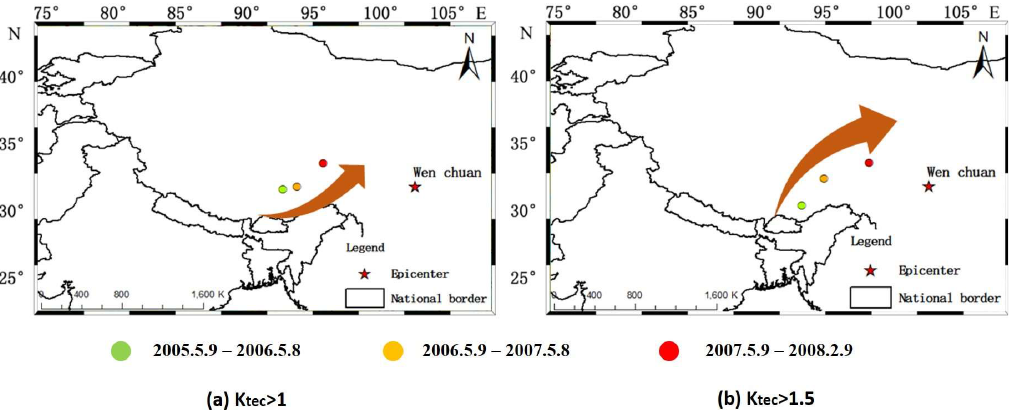
Figure 9. Movement tendency of the TIR anomalies intensity centroid during the Wenchuan earthquake with ( a ) K tec ≥ 1.0; and ( b ) K tec ≥ 1.5.